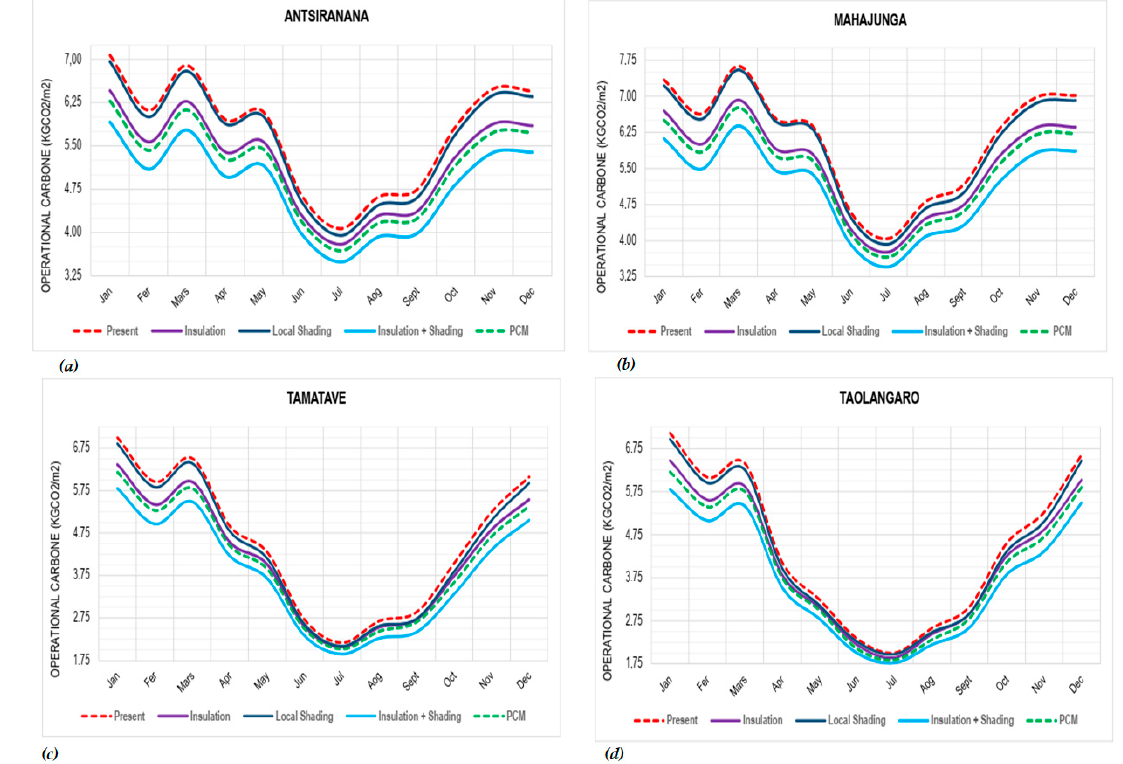
Figure 9. C arbon dioxide produced during the operational phase of office buildings in four cities. Figure 9. Carbon dioxide produced during the operational phase of o ffi ce buildings in four Table 6. Operational carbon in the four cities.